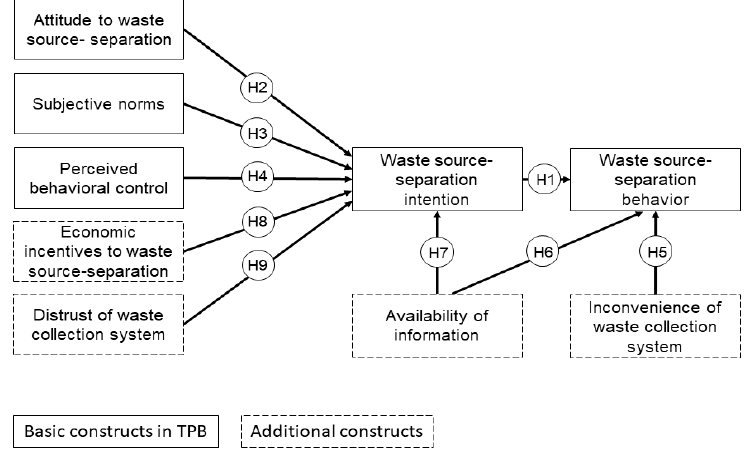
Figure 1. Extended theory of planned behavior.